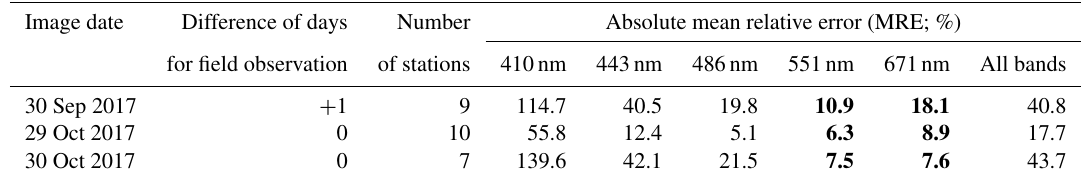
Table 4. The performance evaluation of the atmospheric correction procedure (MUMM) in Galveston Bay (USA) during two field campaigns (29 September and 29–30 October 2017). The MRE remained relatively lower than the blue for the green and red bands (bold fonts). Image date Difference of days Number Absolute mean relative error (MRE; %) for field observation of stations 410nm 443nm All bands 30 Sep 2017 +